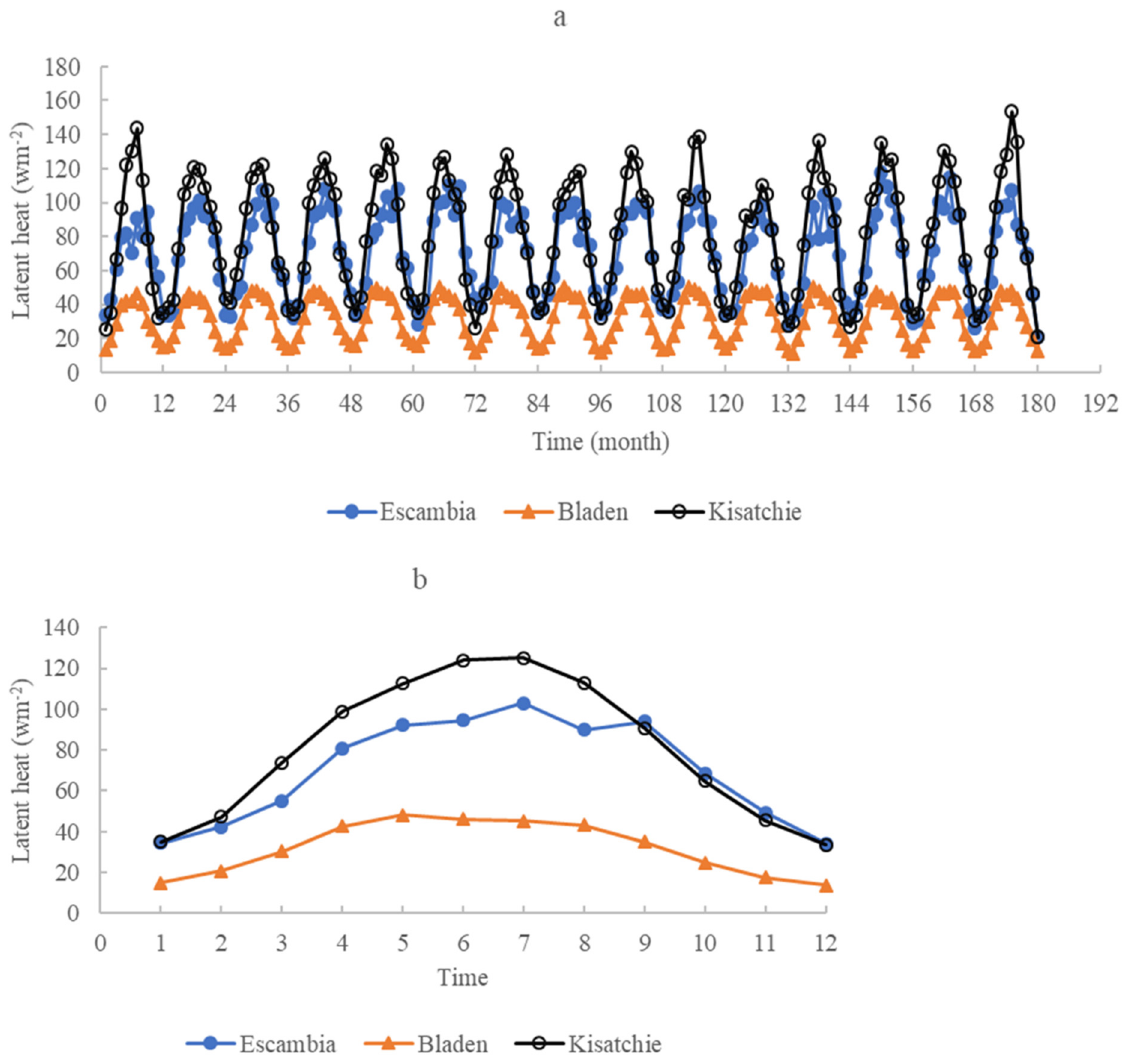
Figure 11. Dynamics of latent heat net flux in Escambia, Bladen, and Kisatchie. ( a ) Monthly and yearly latent heat net flux from January 2000. ( b ) The integrated monthly average of latent heat net flux.